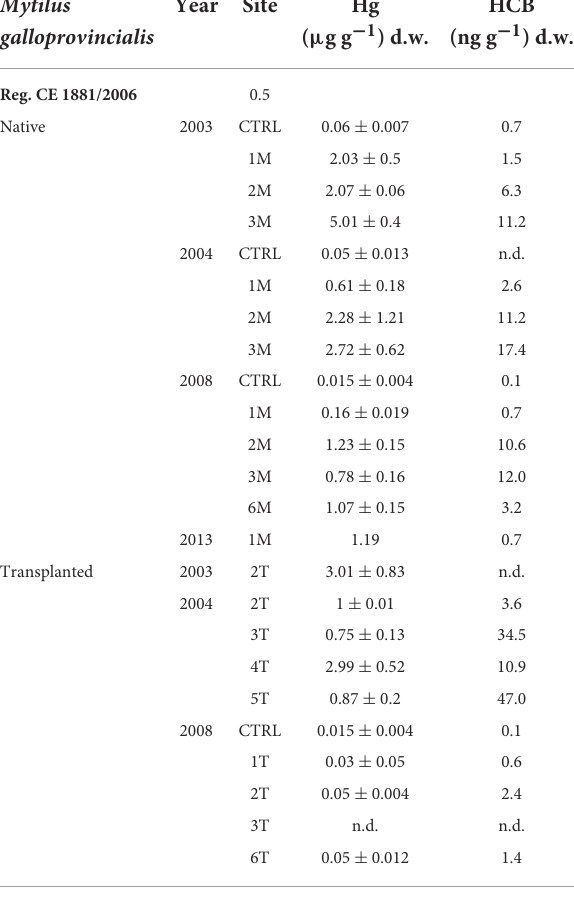
TABLE 4 Contaminant concentrations in native and transplanted mussels ( Mytilus galloprovincialis ).